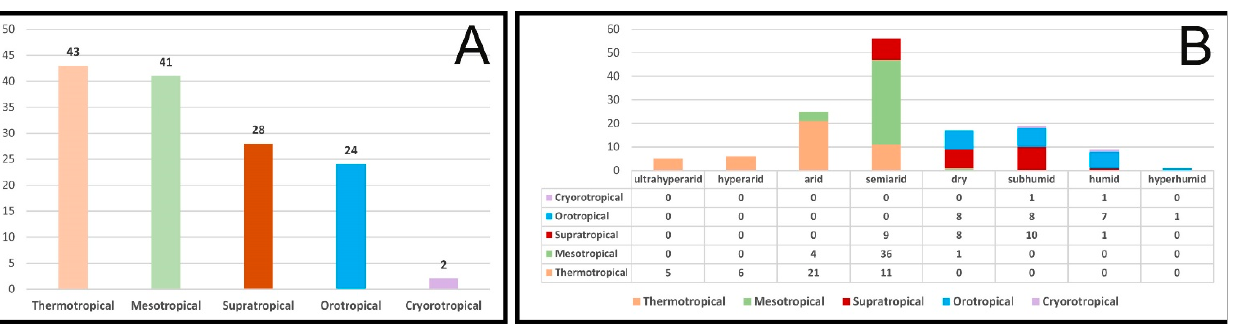
Figure 5. Distribution of localities with endemic and semi-endemic Asteraceae in the Arequipa Region among.bioclimatic belts ( A ) and ombrotypes ( B ).